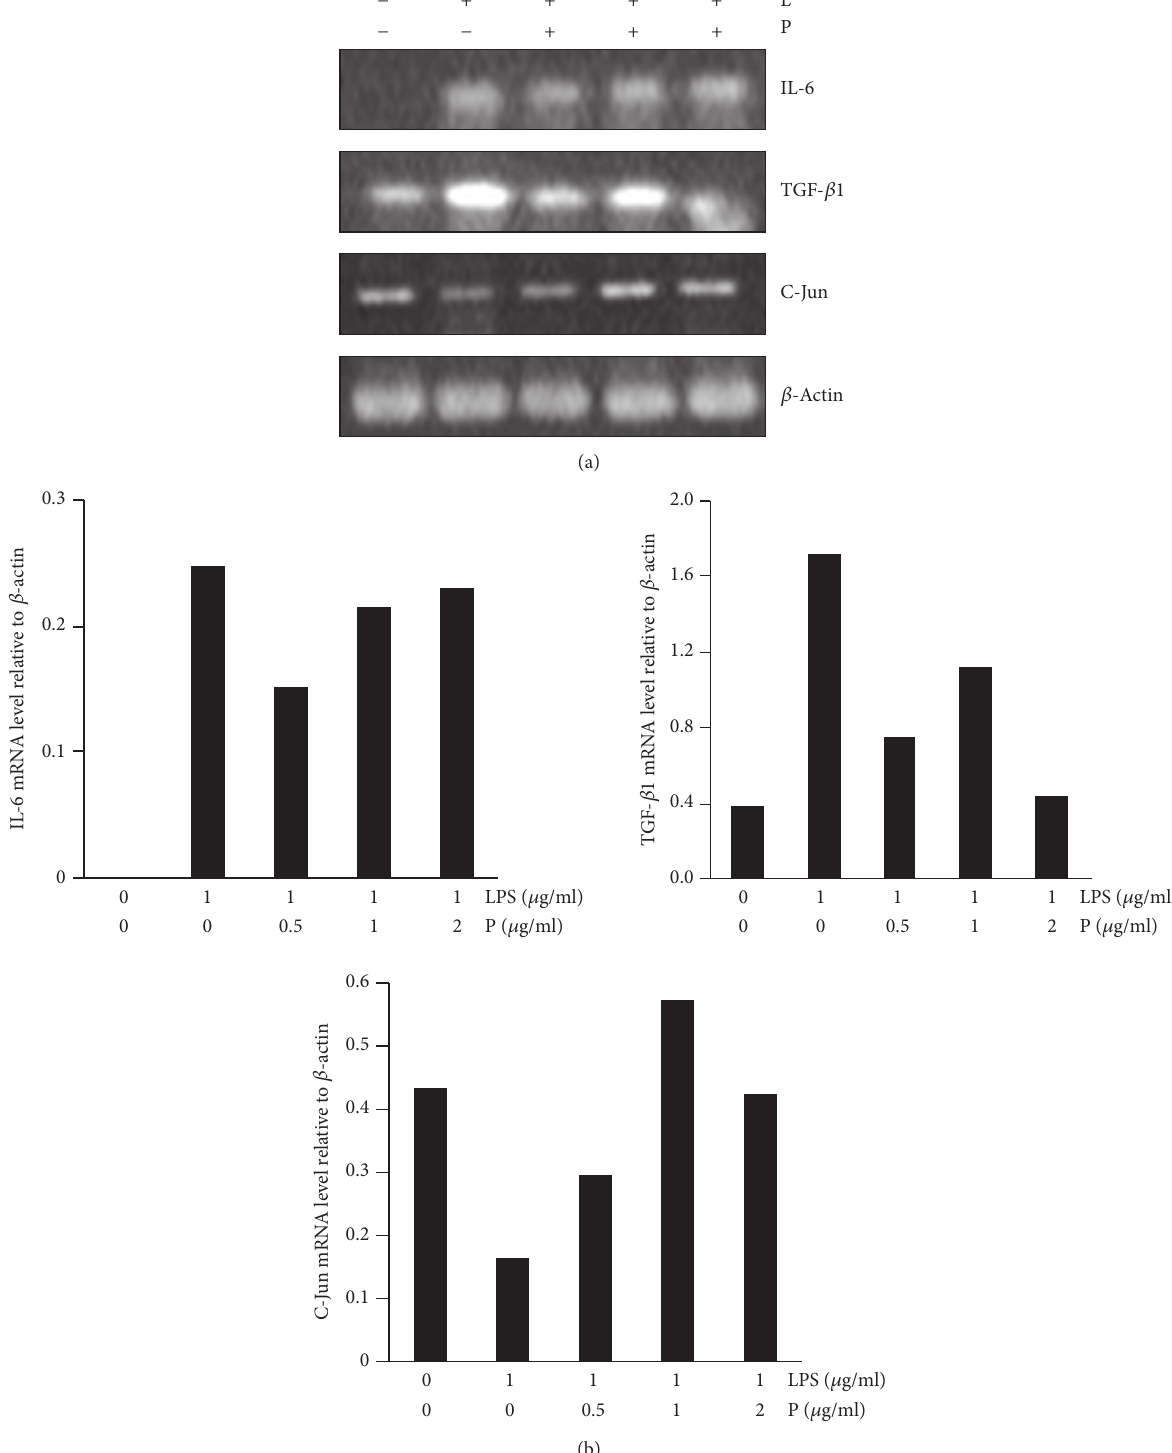
Figure 5: Effect of Periplocin on proinflammatory cytokine expression in synoviocytes from normal Sprague Dawley rats. Synoviocytes were prepared as detailed in Methods. Synoviocytes were incubated with the indicated concentrations of Periplocin for 24h in the presence or absence of LPS (1 𝜇 g/mL) stimulation. After 24 h, the mRNA was measured by RT-PCR and 𝛽 -actin was used as the internal controls, respectively. Representative gels stained for RT-PCR products of IL-6 and TGF- 𝛽 mRNA expression of synoviocytes in AA model rats treated with Periplocin. (a) RT-PCR analysis of inflammatory cytokine genes and related transcription factors and (b) relative amounts of each cytokine gene level were determined by densitometric analysis. Steady-state expression of 𝛽 -actin was used to control equal loading of the PCR product onto gels. The histogram shows the mRNA levels. B: blank; L: LPS; P: